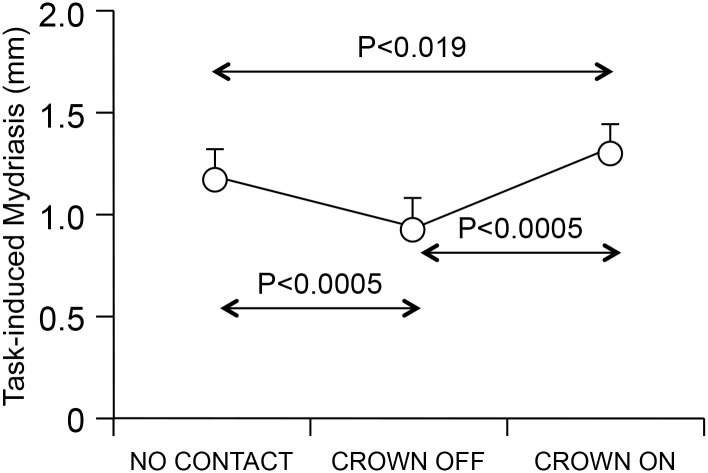
Task-induced mydriasis in different conditions.The average values of the task induced mydriasis have been displayed for each of the three conditions analyzed. The error bars represent standard deviations. For each subject, values relative to the left and right pupils were averaged.